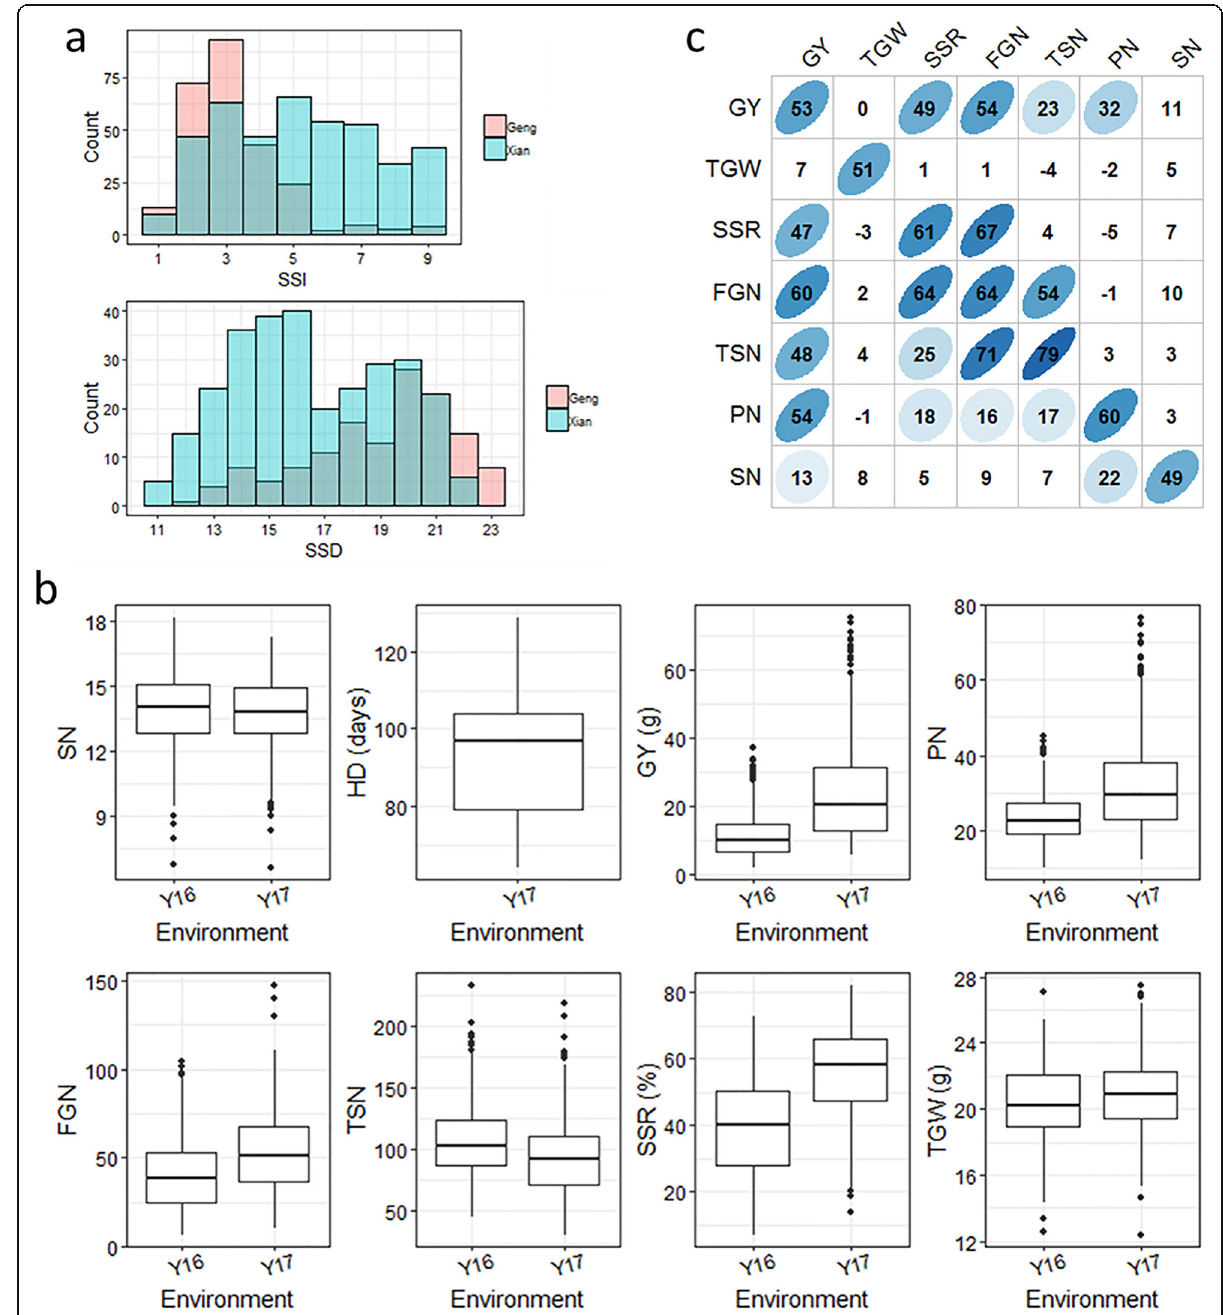
Fig. 1. Phenotypic distributions and correlations. (a) Distributions of SSI (salt stress injury) and SSD (seedling survival days) measured under hydroponic condition. “ Count ” indicated the number of rice accessions. Blue and red indicated Xian ( Indica ) and Geng ( Japonica ) subspecies, respectively. (b) Distributions of traits measured under saline field conditions. SN: seedling number; HD: heading date; GY: grain yield per plot; PN: total panicle number; FGN: filled grain number; TGW: thousand-grain weight; TSN: total spikelet number per plot; SSR: seed setting rate. (c) Pairwise correlations of traits measured under saline field conditions. The correlation coefficients (r) multiplied by 100 on the lower triangle, upper triangle, and principal diagonal show the correlations in 2016, 2017, and between the two years, respectively. The areas and colors of the ellipses show the absolute values of the corresponding r. Right and left oblique ellipses indicate positive and negative correlations, respectively. The values without ellipses indicate that the correlations were not significant at P <